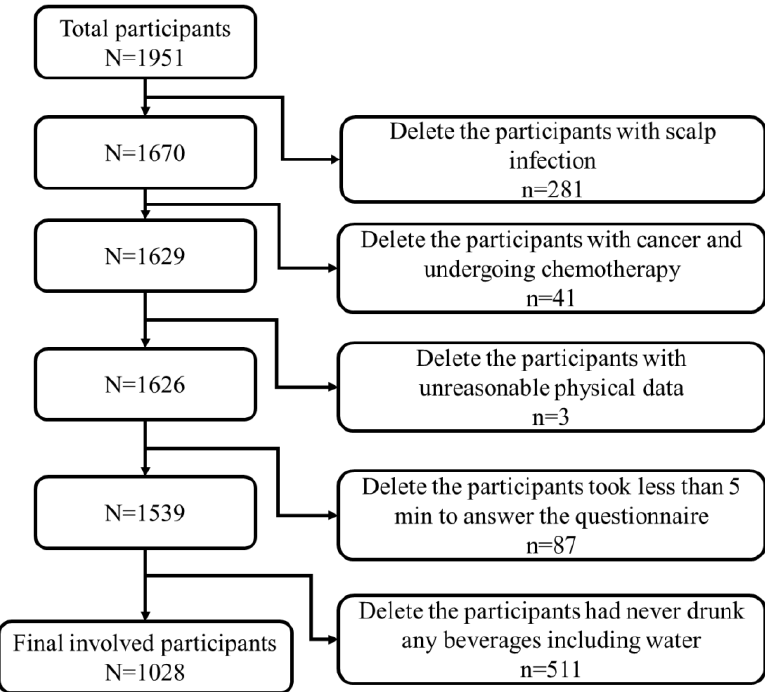
Figure 1. Flowchart of data selection.